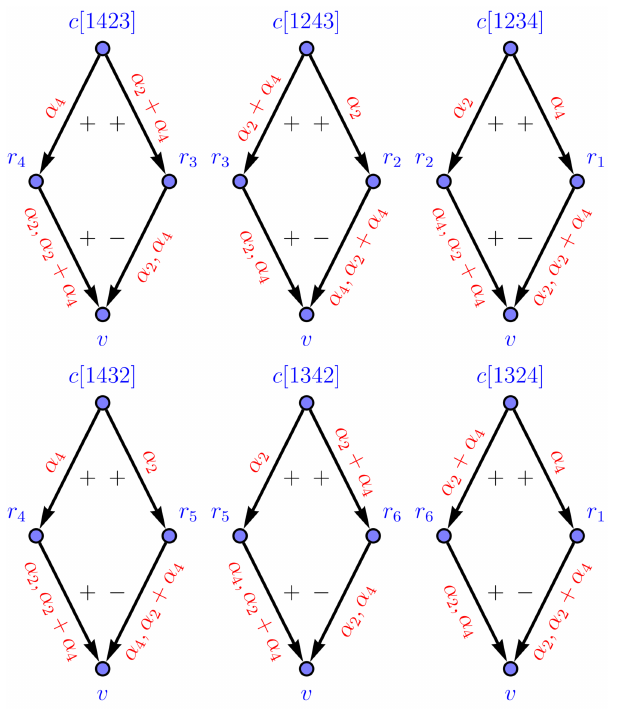
Figure 12 . Example of diamond-compatible sign assignment for the Hasse diagrams H [ P ( σ ) ] , σ ∈ O 4